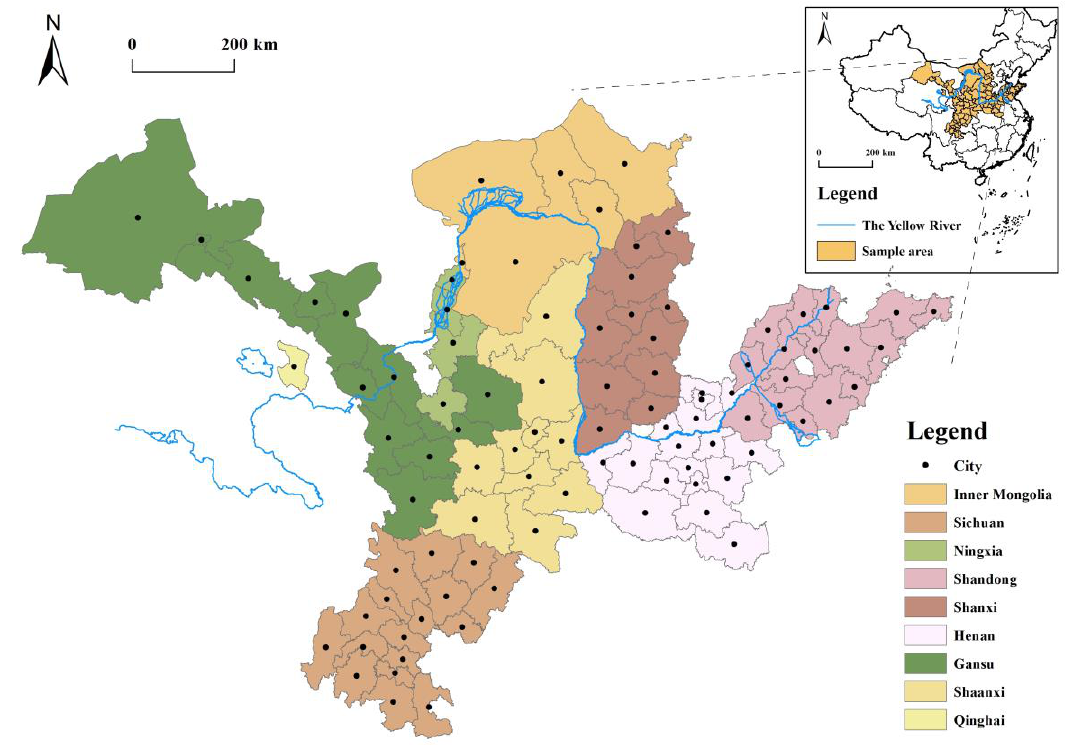
Figure 1. Study Area.